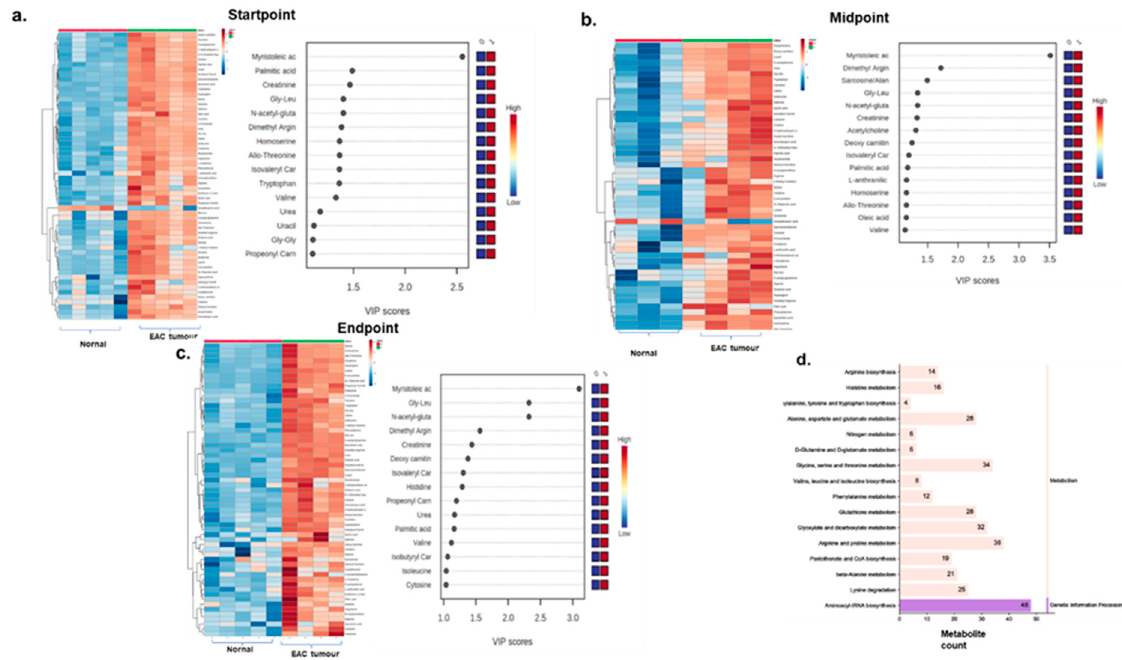
Figure 4. Metabolomics analysis of Normal and EAC tumour samples. Heatmaps depicting signifi- cant metabolites for all three-time points. The blue colour represents downregulation, and the brown colour represents upregulation. VIP score plot obtained from multivariate regression analysis. Top metabolites based on the VIP scores are plotted for ( a ) Startpoint ( b ) Midpoint and ( c ) Endpoint. The notation 0 and 1 represent normal and tumour samples, respectively. The blue colour represents low expression, and the red colour represents high expression. ( d ) Pathway enrichment analysis of significant metabolites. The x -axis represents metabolite count, and the y -axis represents pathways.